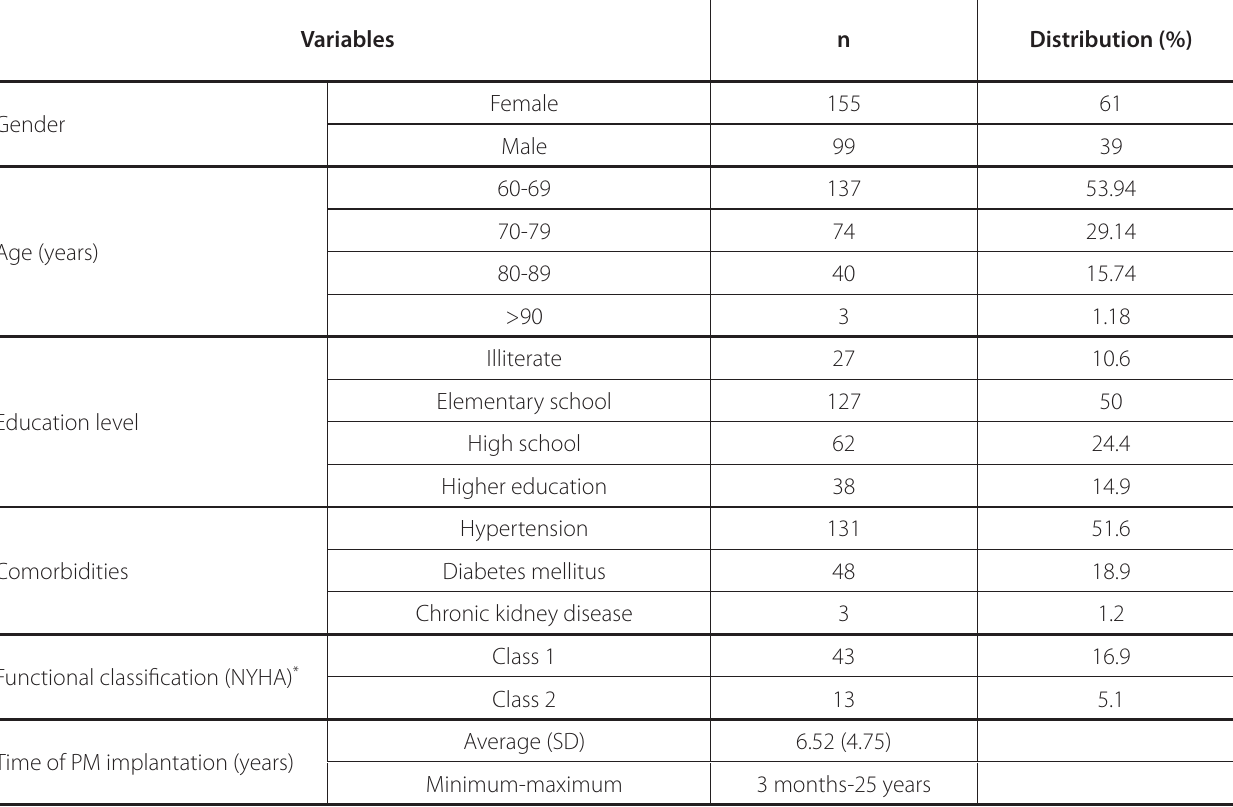
Table 1 . General and clinical characteristics of the elderly patient population